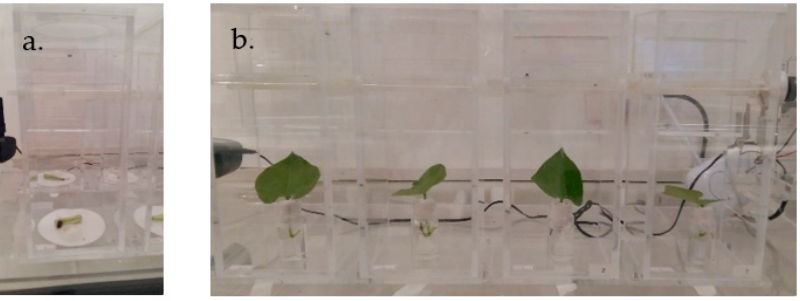
Figure 6. Release devices installed inside the chamber: ( a ) segments of bean pods offered to E. heros adults; ( b ) bean leaves offered to D. speciosa adults .